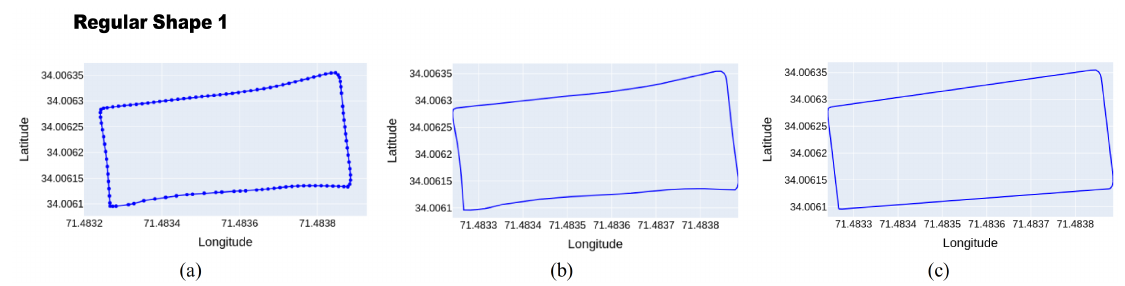
Figure 2. Comparison of boundary detection algorithms ( a ) Actual GPS Plots, ( b ) concave hull using KNN and ( c ) convex hull using Delaunay Triangulation.